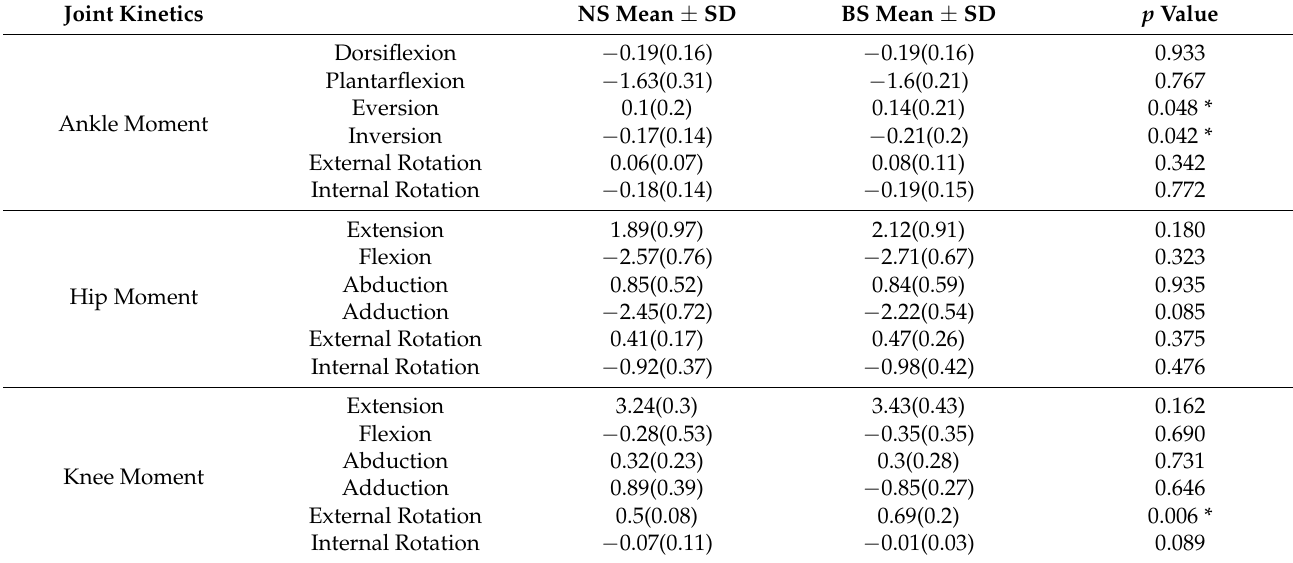
Table 2. Comparison of all kinetic variables between NS and BS during the SLL phase when jumping from 40 cm heights. Joint Kinetics p Value